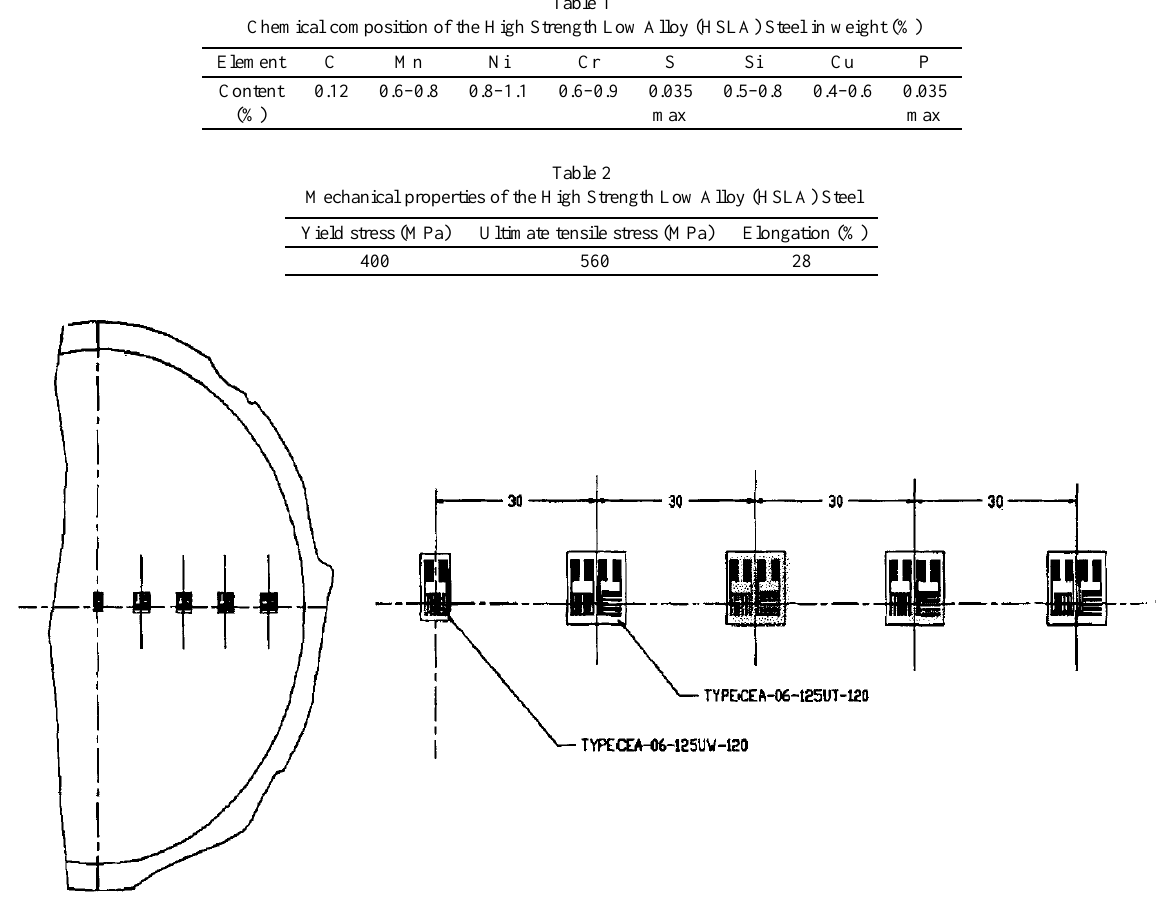
Fig. 1. Schematic of the location of strain gauges on the HSLA steel circular